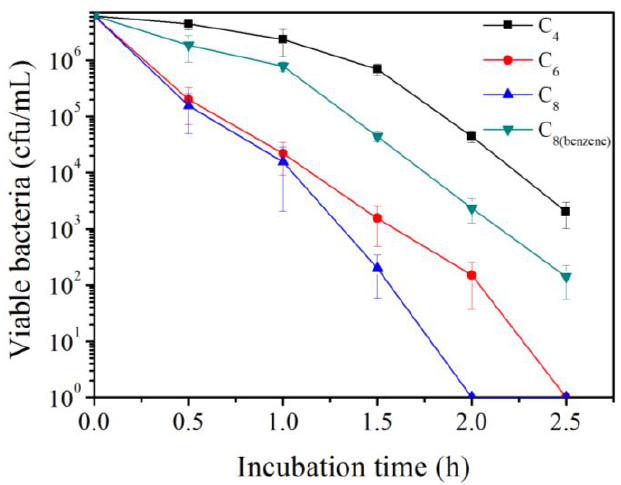
Figure 2. The time-kill curve of synthesized Polymer C 4 , C 6 , C 8 , C 8(benzene) against multidrug-resistant Pseudomonas aeruginosa . Approximately 6.25 × 10 6 CFU/mL bacterial cells were incubated, respectively, with 32 μg/mL polymer at 25 °C for 0.5, 1, 1.5, 2 and 2.5 h.